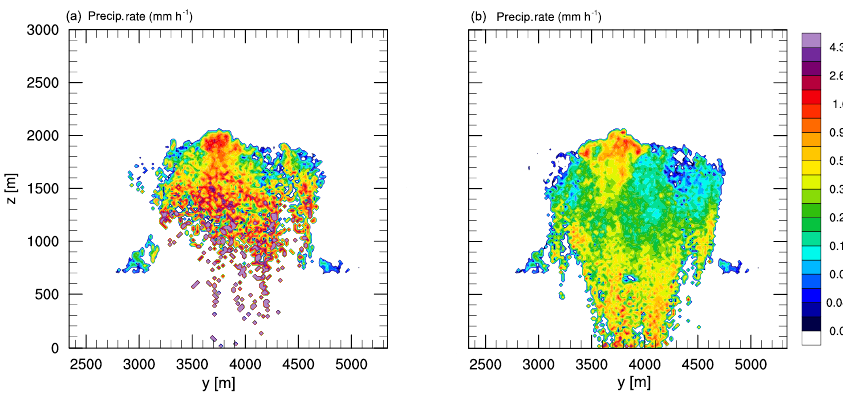
Figure 16. Vertical cross sections of the precipitation rate for the reference case (a) and the splitting case S20 (b) .